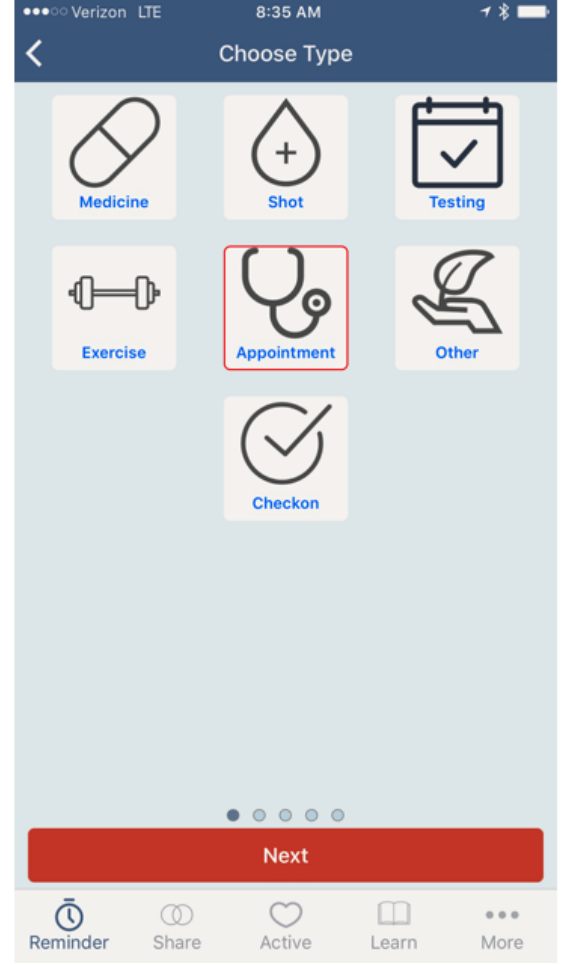
Figure 2. Initial detail screen when “Reminder” is selected from the navigation panel of the